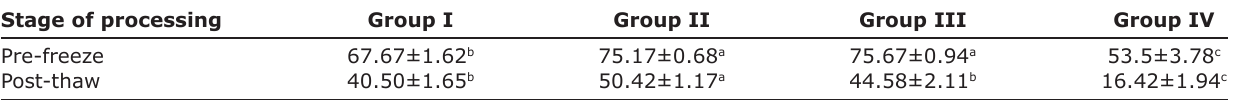
Table-1: Effect of varying cholesterol levels in extender on pre-freeze and post-thaw progressive motility (per cent, Mean±SEM) of Malabari buck spermatozoa (n=12). Stage of processing